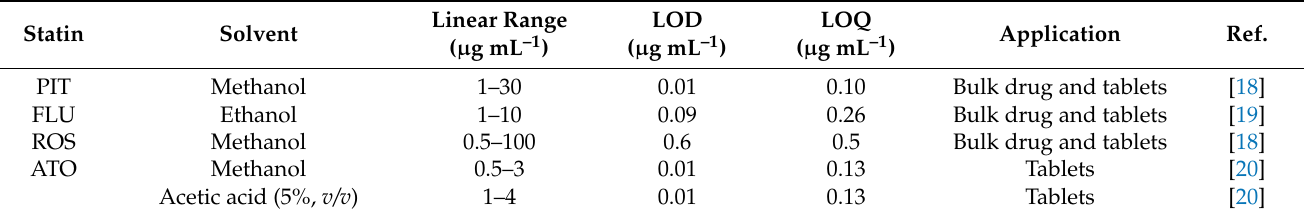
Table 7. Analytical characteristics of the reported spectrofluorimetric assays for determination of